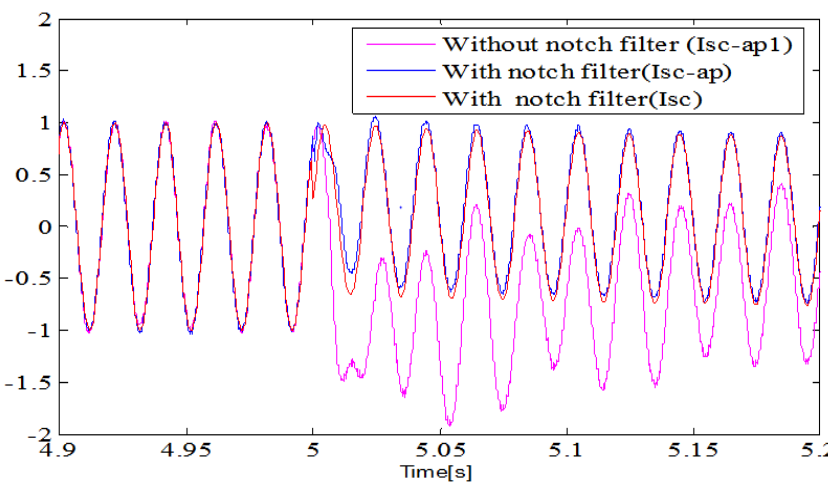
Figure 10. The C phase currents under condition of a Phase-C ground